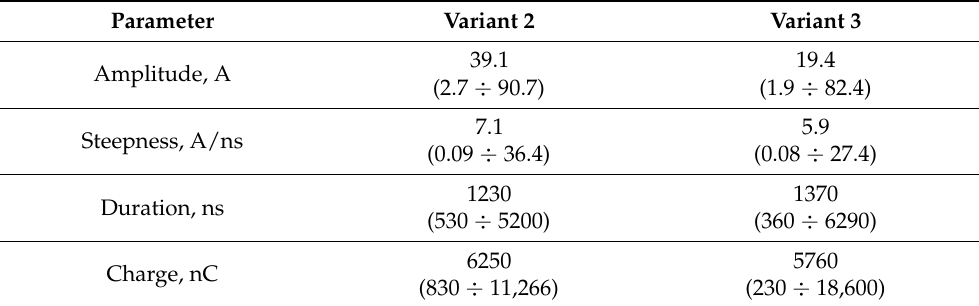
Table 2. Parameters of current impulses recorded on the model of a lightning diverter on the radome’s outer surface for different variants of its lightning protection (average value,